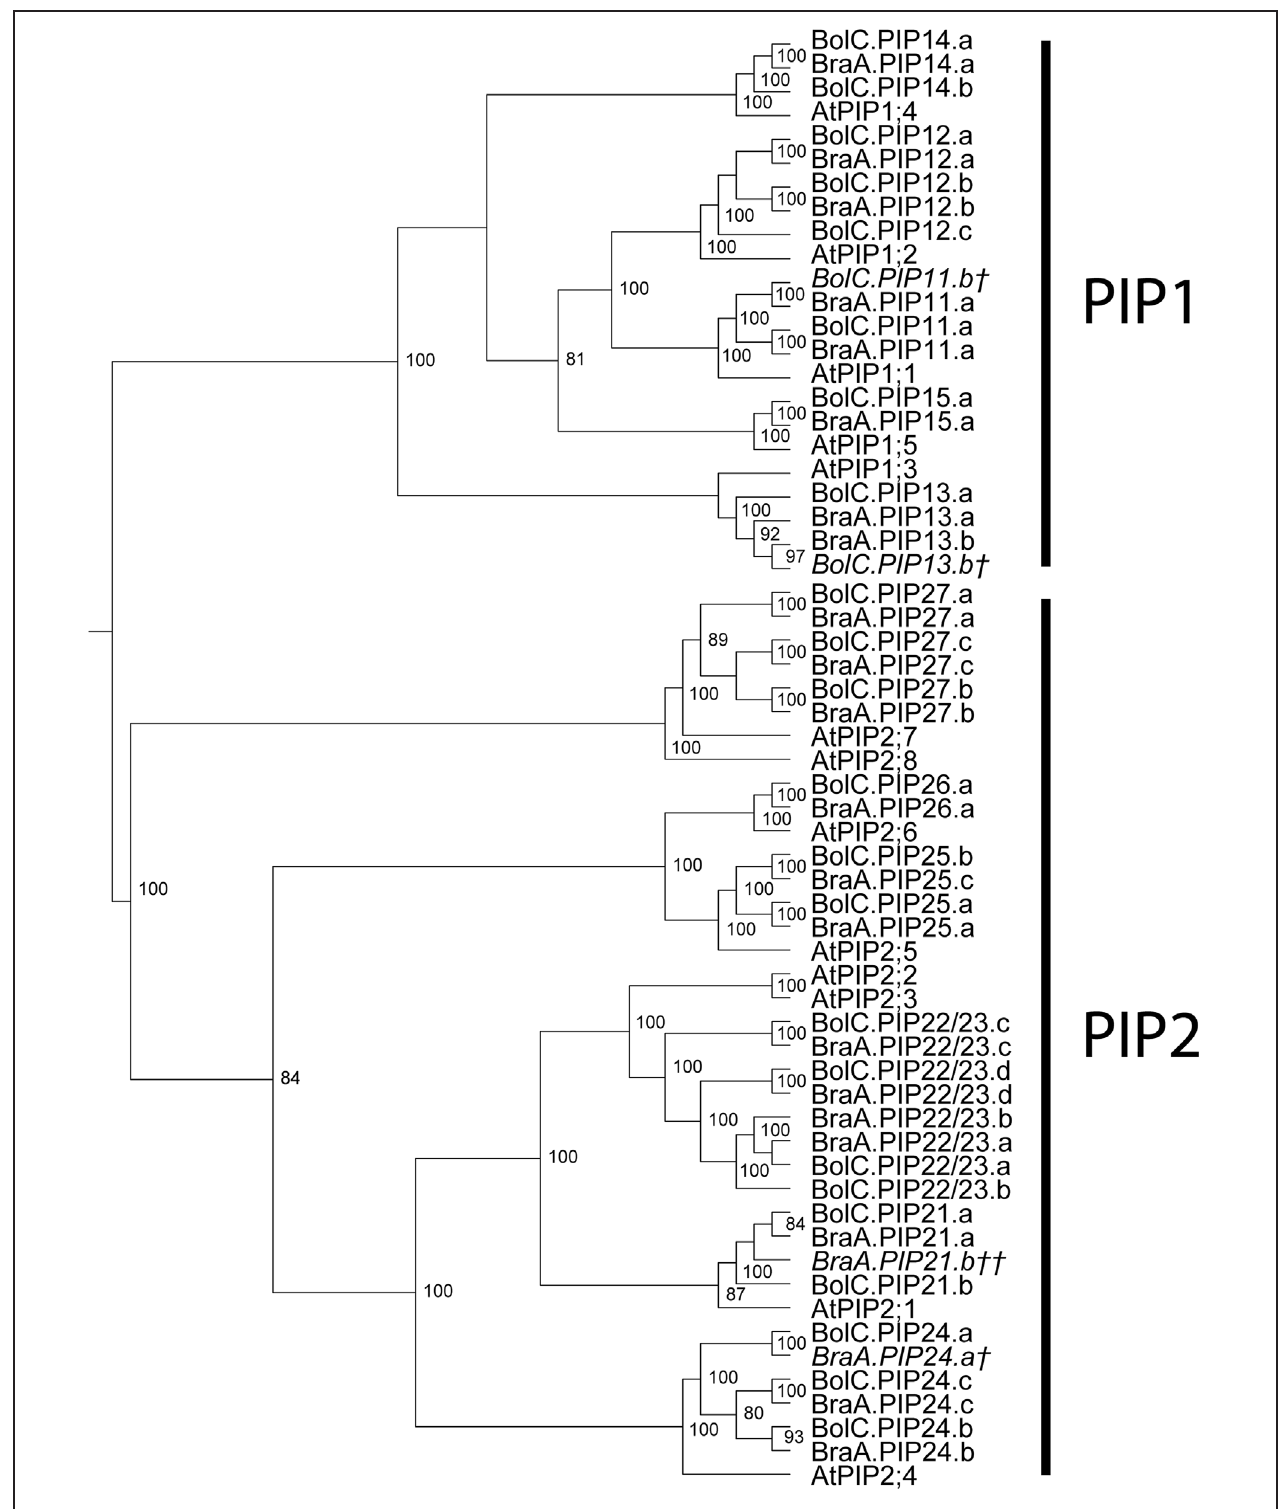
FIGURE 3 | Phylogeny of PIPs. Phylogenetic tree derived from PIP cDNA sequences of B. oleracea , B. rapa, and A. thaliana using Bayesian phylogenetic inference. Numbers beside the nodes indicate the posterior probability values > 75%. Gene IDs which are written in italics and/or